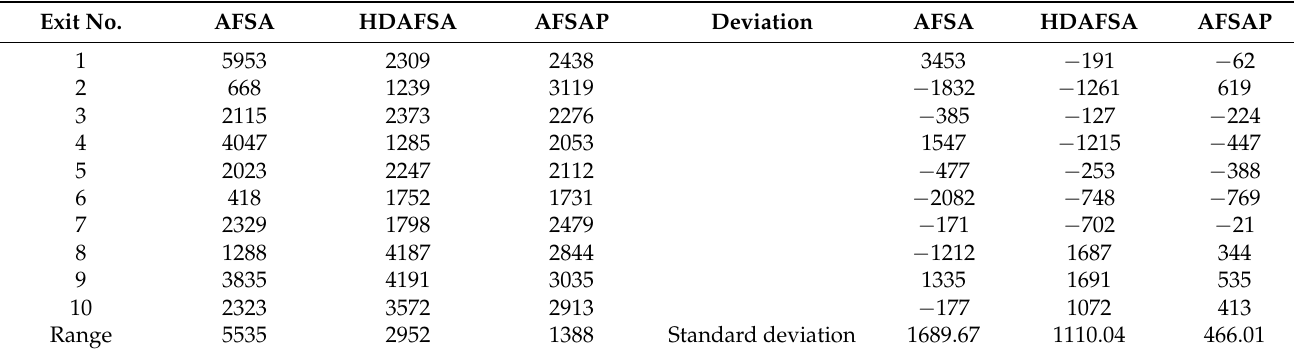
Table 3. Distribution of evacuees from 10